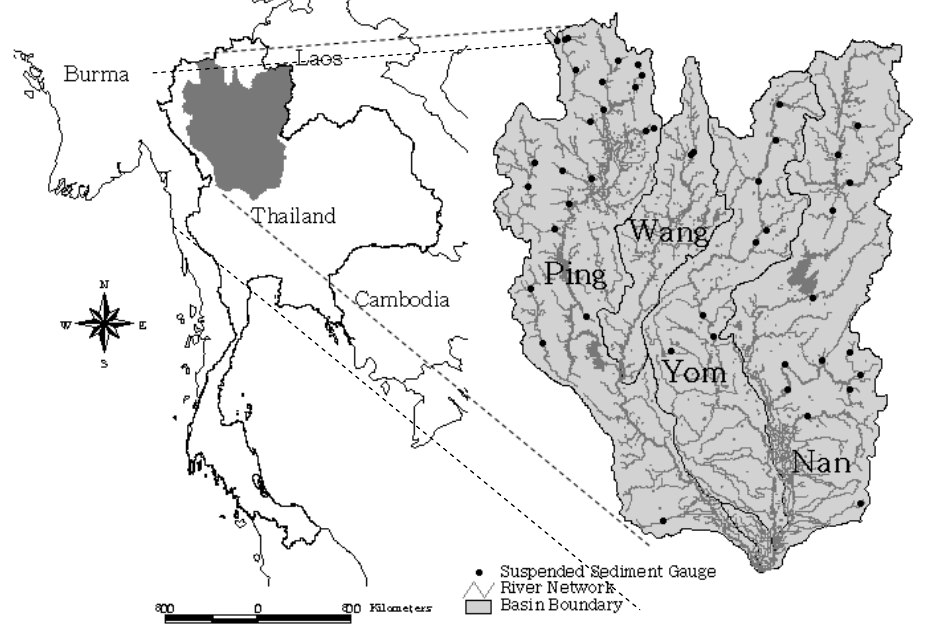
Figure 1. The study area showing the locations of suspended sediment gauging